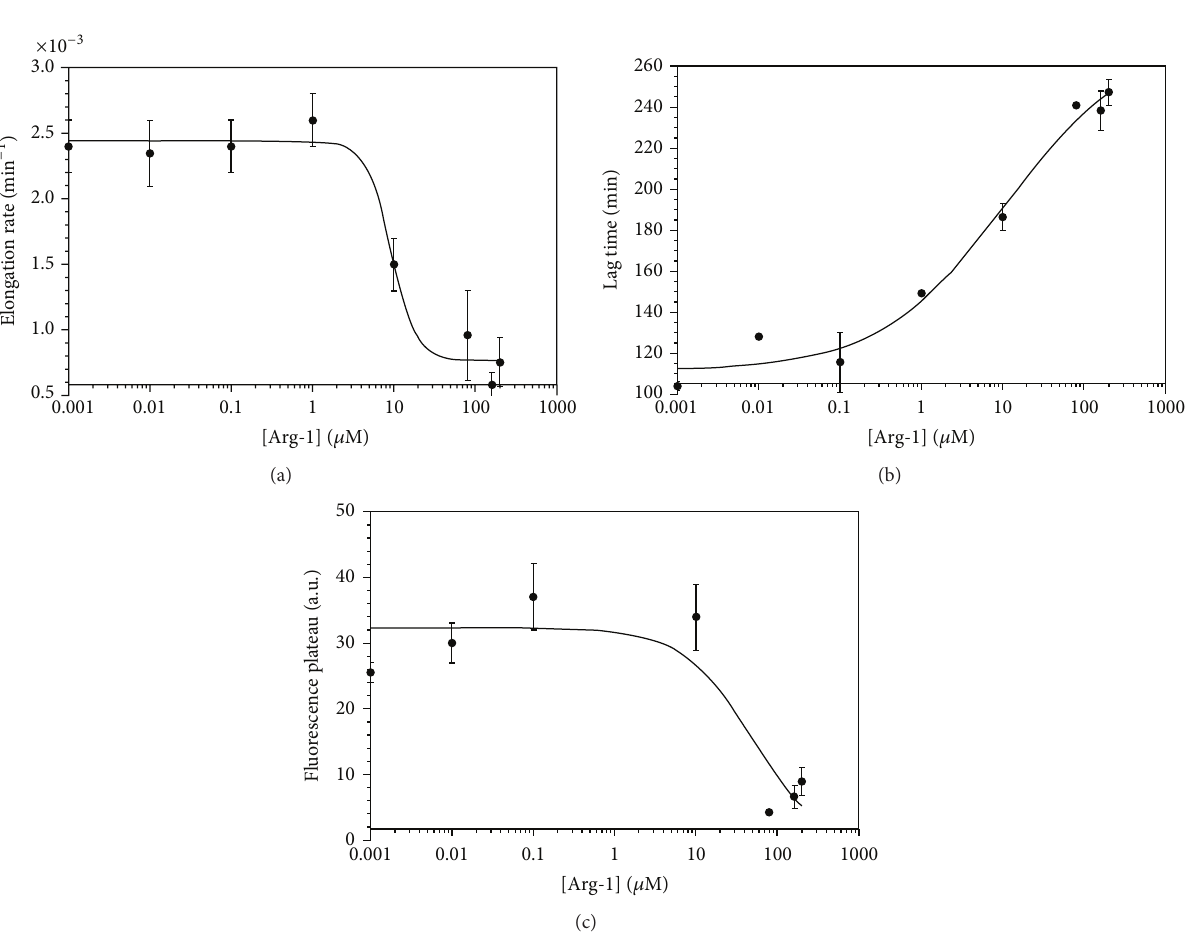
Figure 7: Dependence of kinetic parameters for the fibrillization of 80 𝜇 M WT amylin (see Figure 6) on the concentration of Arg-1 inhibitor. Experiments were done in duplicate in the presence of 150mM NaCl. Data points are average values for the kinetic parameters, uncertainty bars are SEM values from the duplicate reactions, and curves are four-parameter fits of the inhibition data to the IC 50 equation. The IC 50 values were 9.1 ± 5.2 𝜇 M for the elongation rates (a), 11.0 ± 12.4 𝜇 M for the lag times (b), and 50 ± 80 𝜇 M for the steady-state fluorescence plateaus